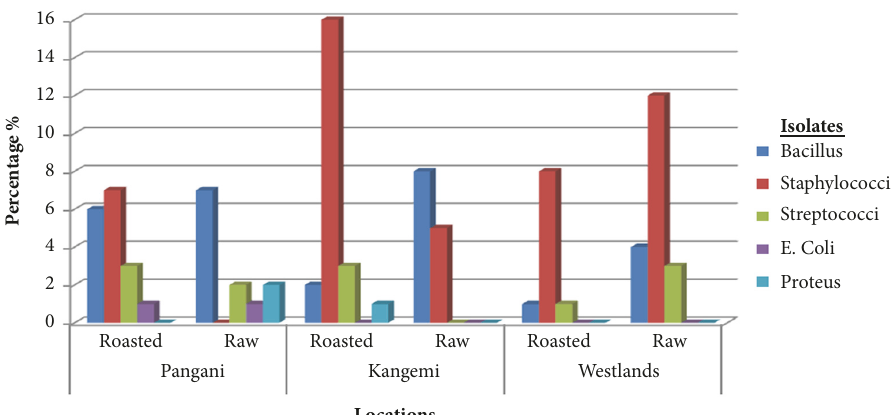
Figure 1: Prevalence of the five genera of bacteria isolated from African sausages sampled from Pangani, Kangemi, and Westlands estates, Nairobi County, Kenya: n=100.